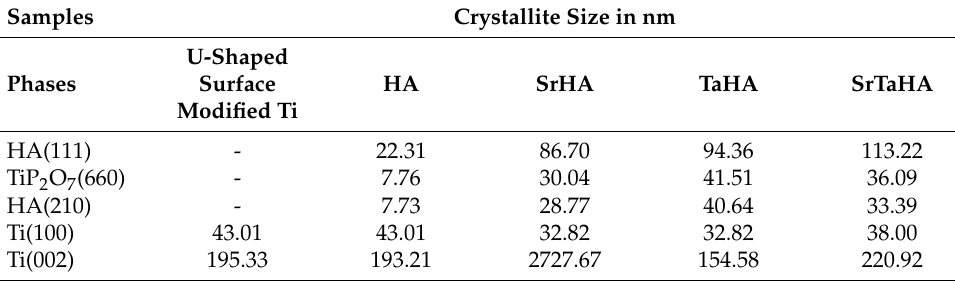
Figure 4. X-ray diffraction patterns of ( a ) Surface-Modified Ti, ( b ) HA, ( c ) TaHA, ( d ) SrHA, ( e ) SrTaHA. Table 2. Crystallite size of different phases of samples obtained in